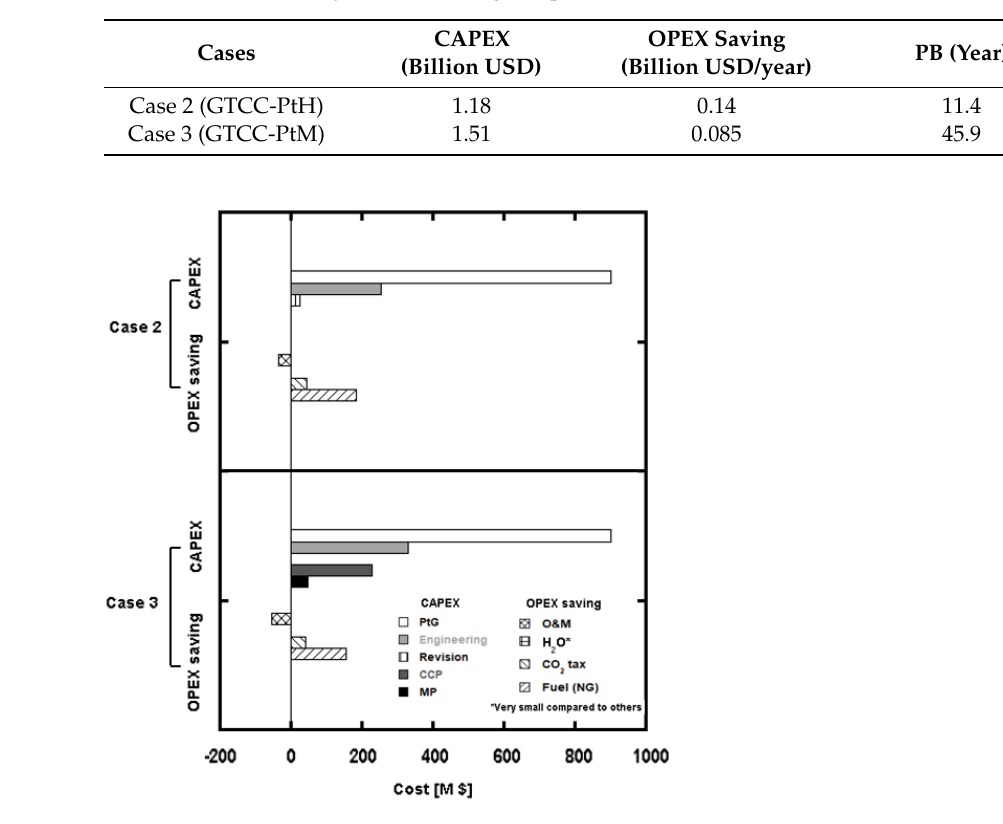
Table 9. Economic analysis results using NG price scenario 1.